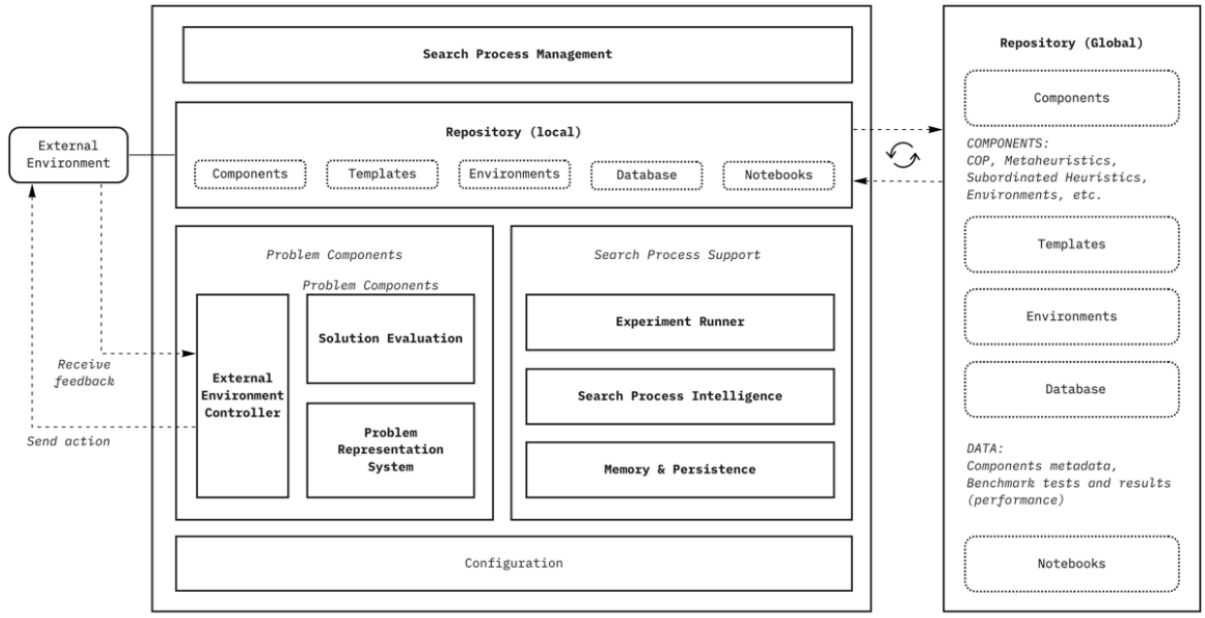
Figure 5. Proposed framework architecture—high-level view of the main